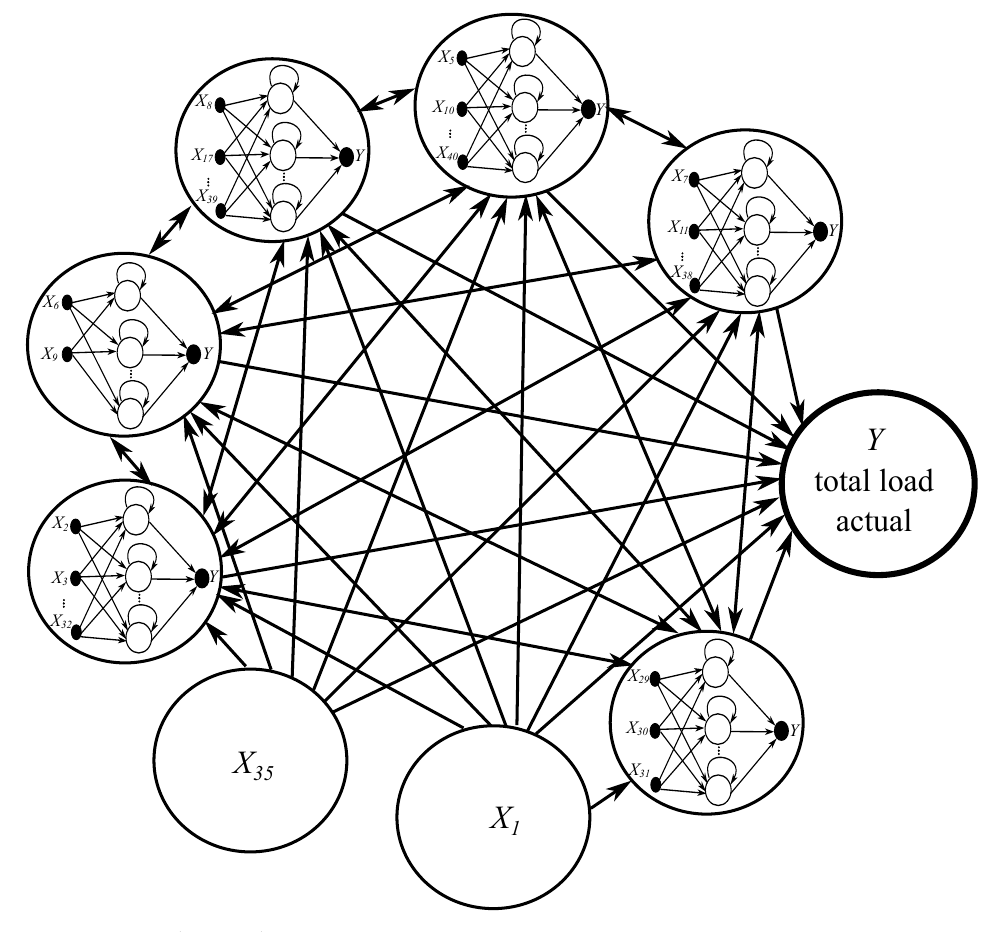
Figure 4. Sample nested